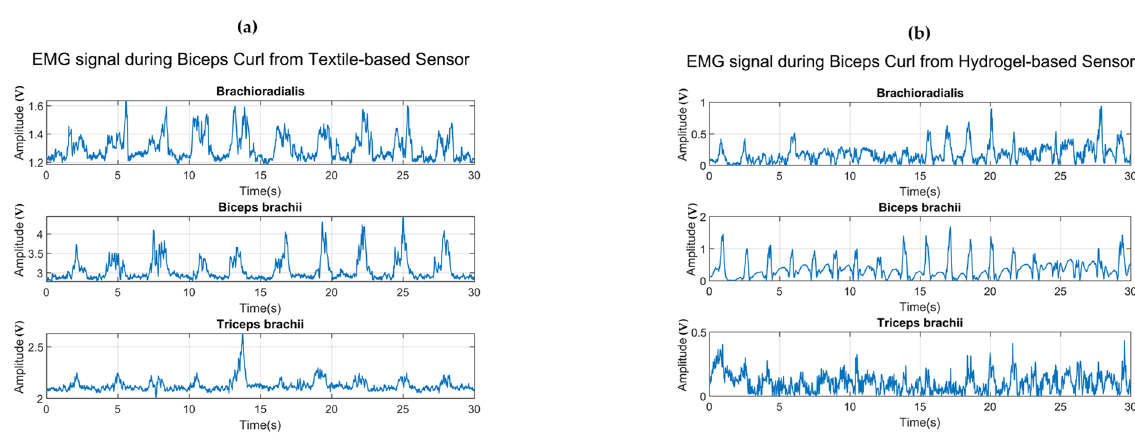
Figure 8. ( a ) EMG envelope data recorded by the textile-based sensor, ( b ) the hydrogel-based sensor.